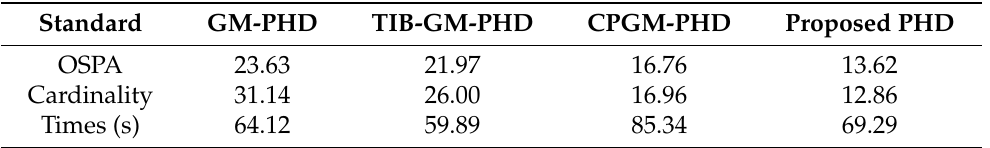
Table 3. Performance comparison (Simulation is based on Scenario 2 in 200 Monte Carlo runs.